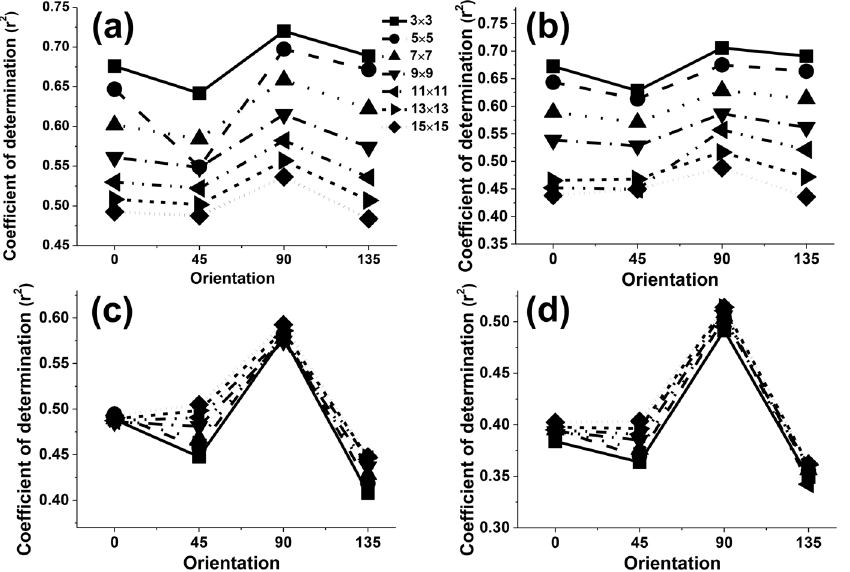
Figure 2. The effect of the orientation parameter on the values of adjusted r 2 for different texture features calculated using 3 pixel displacement and 3 × 3, 5 × 5, 7 × 7, 9 × 9, 11 × 11, 13 × 13, and 15 × 15 moving window sizes.